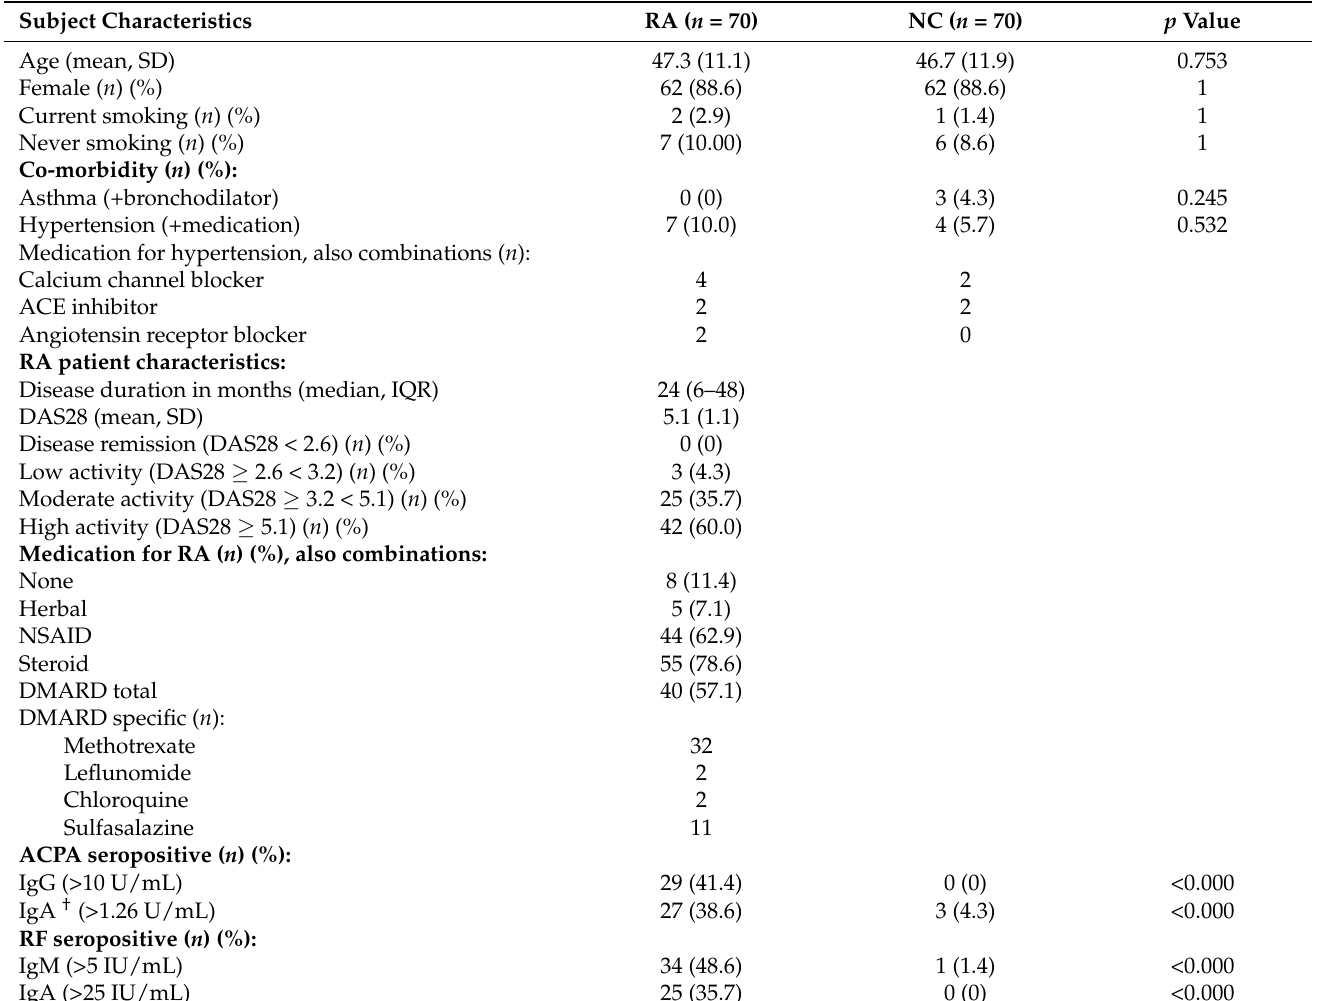
Table 1. Characteristics of patients with rheumatoid arthritis (RA) and non-RA controls (NC) modified after